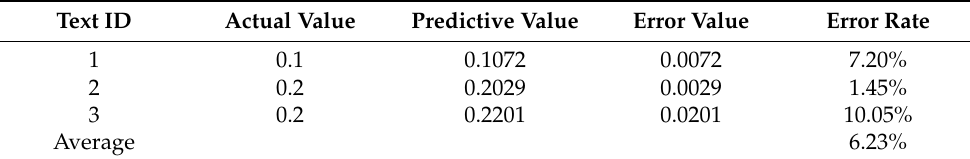
Figure 8. Prediction accuracy of the monitoring model. Table 7. Error values of the test sample.